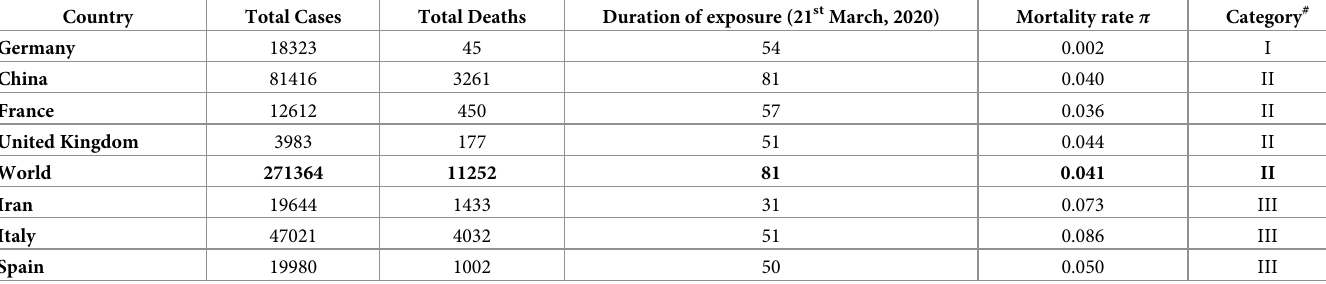
Table 1. Duration of exposure and mortality rates in different countries due to COVID-19 on 21 st March, 2020. Country Total Cases